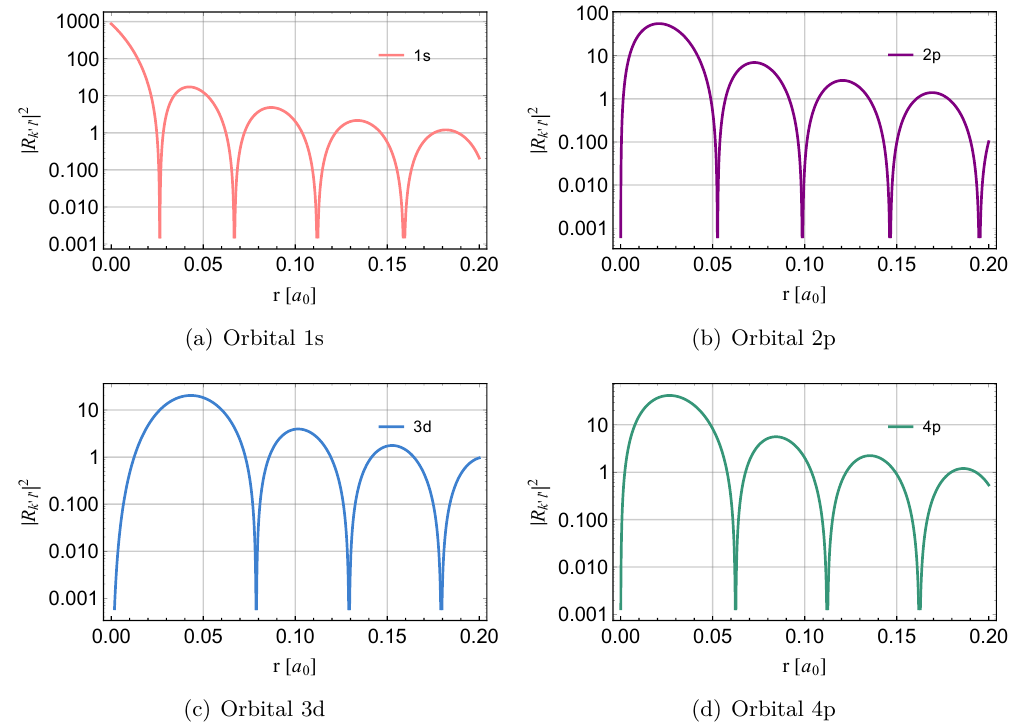
Figure 8 . The radial wave-function R k 0 l 0 ( r ) of the outgoing electron with recoil energy E R = 50 keV for